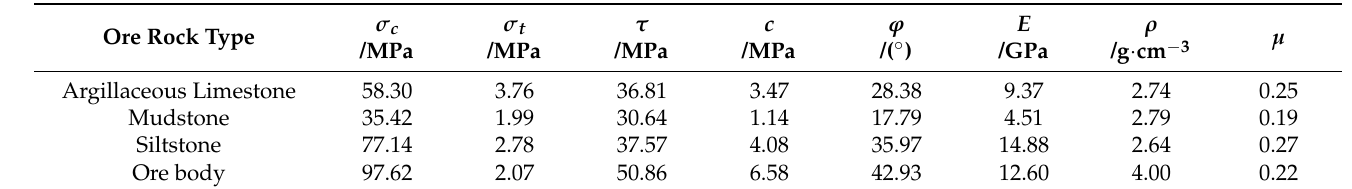
Table 1. Physical and mechanical parameters of Bainiuchang’s ore rocks.